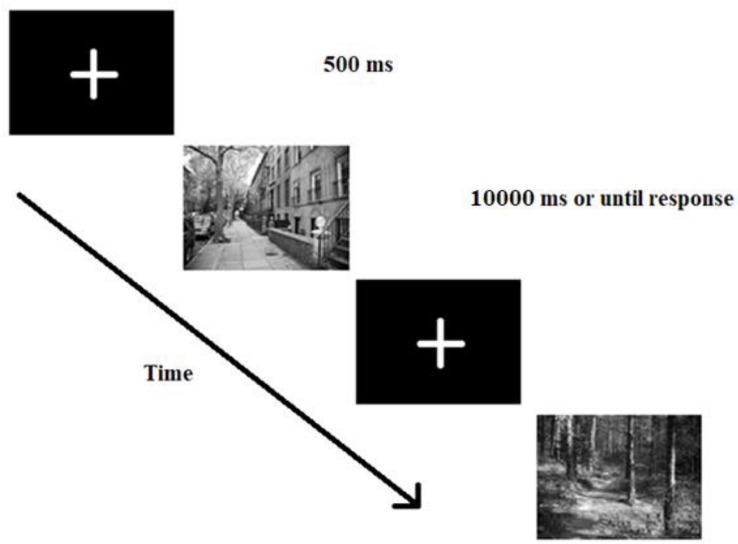
Trial presentation sequence used in both experiments. First, participants saw a fixation cross for 500 ms, then a real-life scene appeared with one of the target objects on it. Participants’ task was to find the target as quickly as possible and indicate the target’s location using a touch-screen monitor.